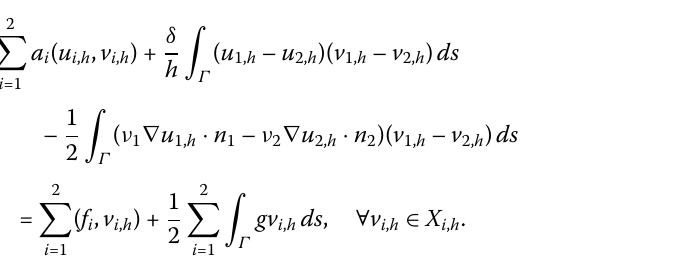
Algorithm 1 (The coupled scheme) Find u i , h ∈ X i , h , i = 1,2, such